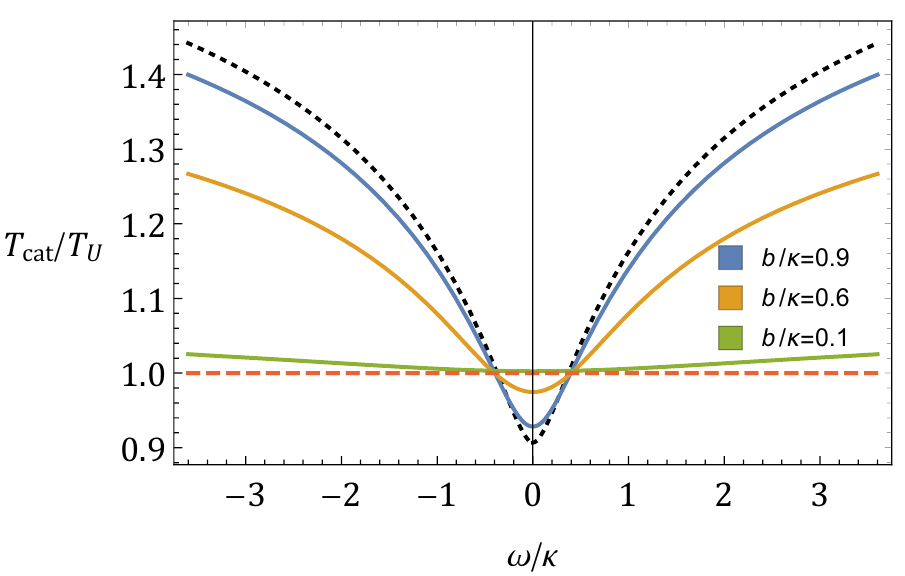
Figure 5 . E(cid:11)ective temperature along the Infrator (catenary) worldline. The Unruh temperature, T U , is indicated by a red dotted line. The Parator (cusped) motion temperature, T cus , is indicated by a black dotted line. At large values of v min the Infrator temperature asymptotes the Parator temperature. As small values of v min the Infrator temperature asymptotes the Unruh temperature.